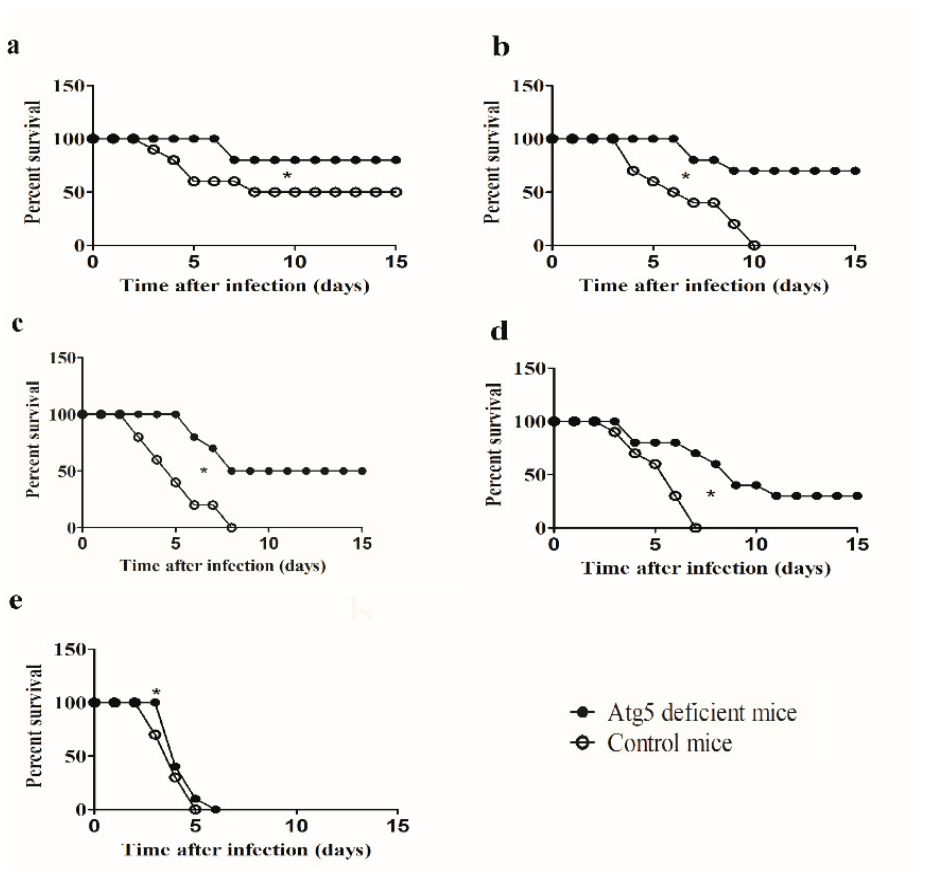
Figure 1. Survival of Atg5-deficient mice and control mice infected with the live vaccine strain (LVS) of F. tularensis . Groups of 10 mice were infected with ( a ) 5 × 10 4 ( b ) 5 × 10 5 ( c ) 5 × 10 6 ( d ) 5 × 10 7 , or ( e ) 5 × 10 8 of bacteria per mouse intradermally. Infected animals were monitored for 15 days. The Prism GraphPad5 software was used to generate graphs and calculate statistical values. * p < 0.05 was considered significant in comparison to the control mice. Table 1. Mean time to death (MTTD) of Atg5-deficient mice and control mice infected with F.